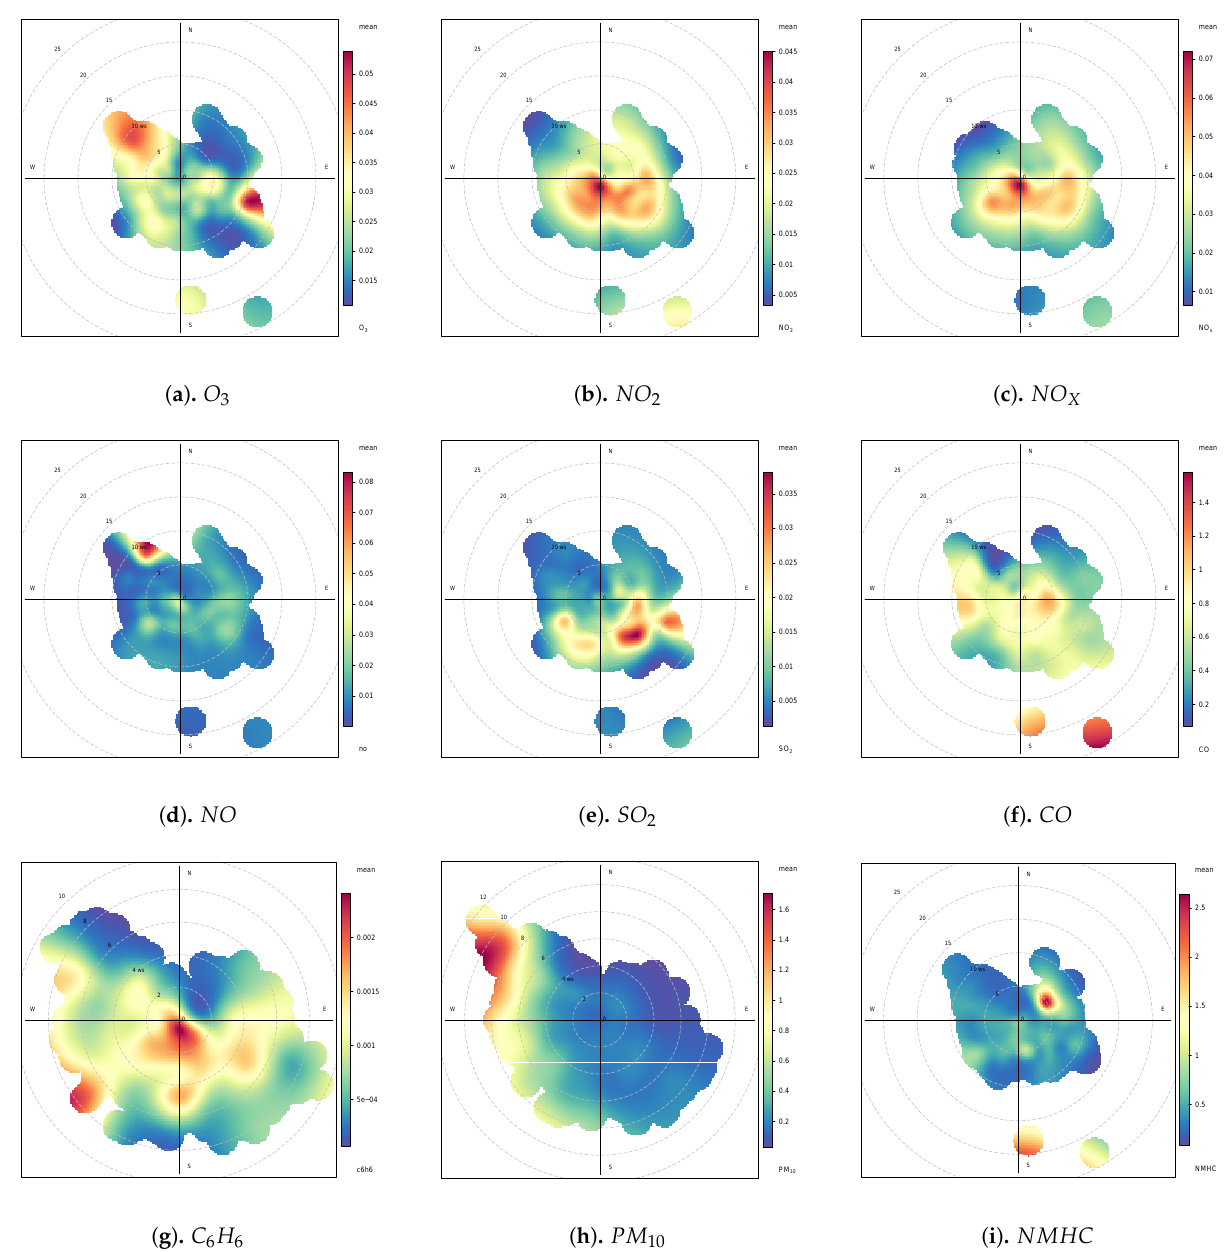
Figure 8. Air Pollutant Concentration according to the Wind Direction and Speed from 2012 to 2017. The State of Kuwait faces a growing risk of health-related problems due to the poor air quality originating from its various industrial and domestic activities. Dust